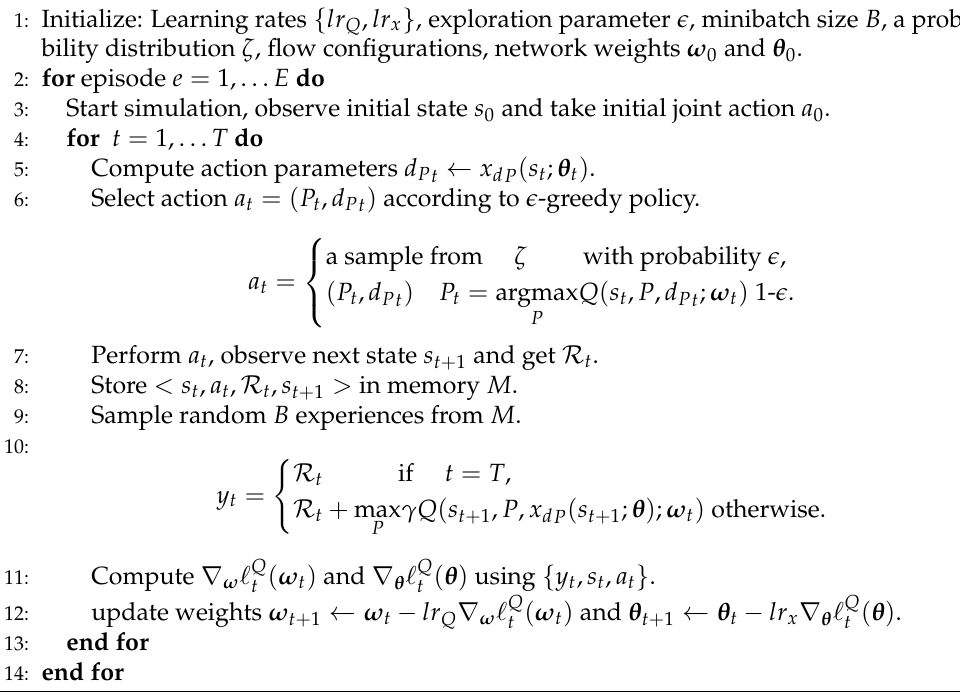
Figure 5. Flow diagram describing the dynamic of the proposed framework. Algorithm 1 Traffic Signal Control Using Parameterized Deep